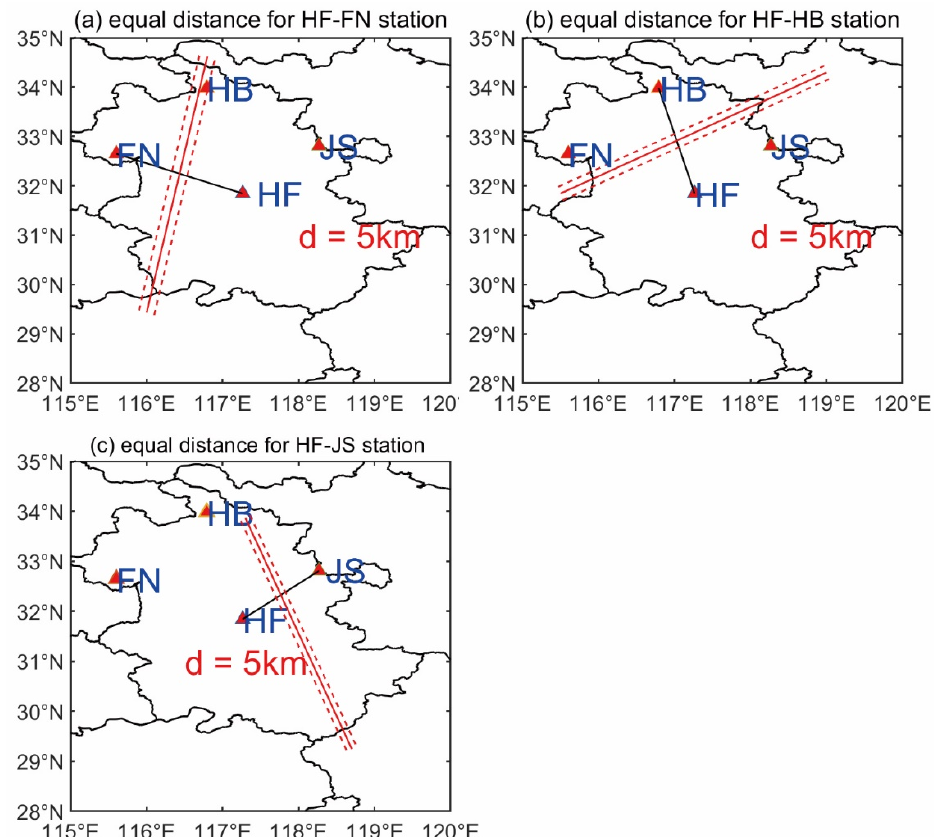
Figure 7. Observations at equal distance for ( a ) HF–FN station, ( b ) HF–HB station, and ( c ) HF–JS station links; d is 5 km, meaning within 5 km on both sides of the vertical bisector.